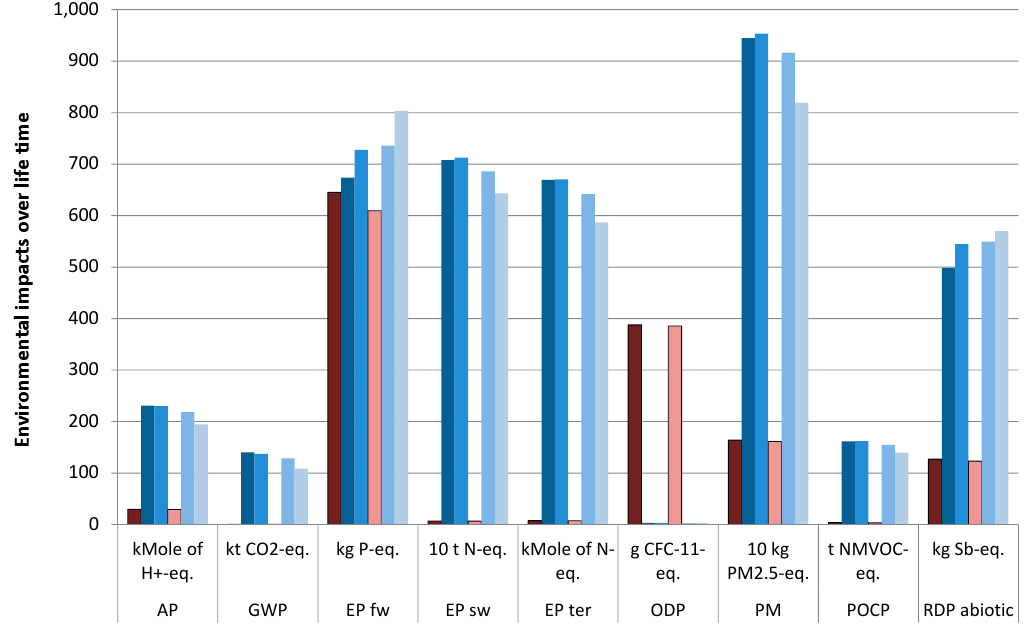
Figure 6. Environmental impacts of life cycle stages related to hydrogen production over 20 years (Germany).